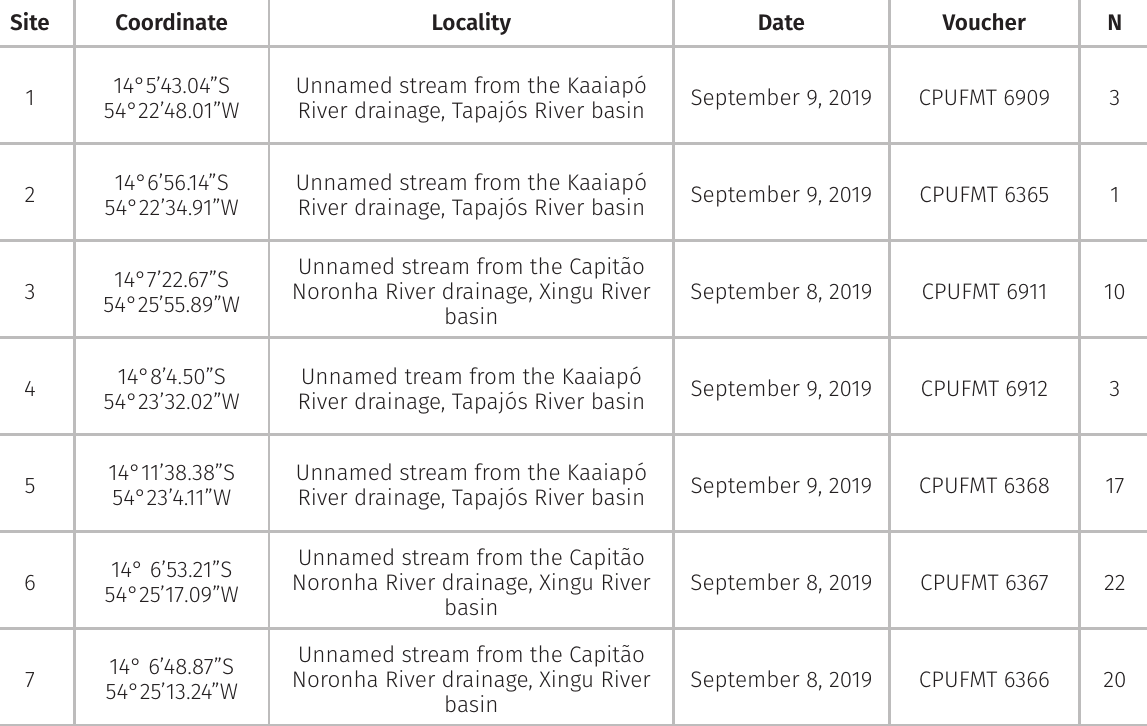
Table I. Geographical distribution and number of individuals (N) of Characidium xavante sampled at new sites in the upper Tapajós and upper Xingu River basins, all from Paranatinga municipality, Mato Grosso State, Brazil. All collected by Hugmar Pains da Silva